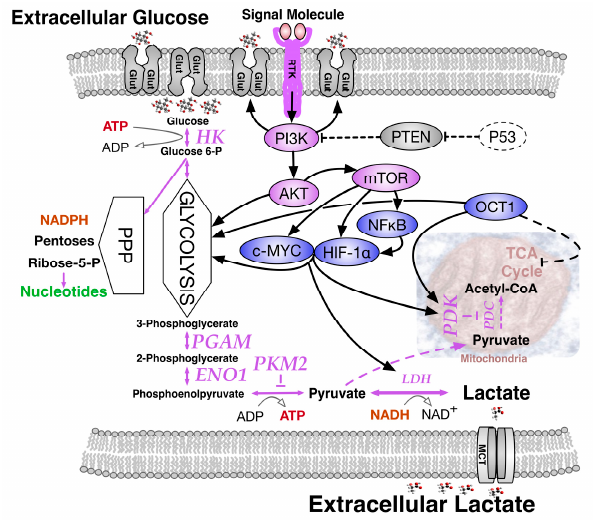
Figure 2. Molecular changes driving the Warburg effect. The shift to aerobic glycolysis in tumor cells reflects multiple oncogenic signaling pathways. Downstream from an active RTK, receptor tyrosine kinase, PI3K, Phosphatidylinositol 3-kinase activates AKT, protein kinase B/Akt strain transforming, stimulating glycolysis by directly regulating glycolytic enzymes. It also activates mechanistic target of rapamycin, mTOR, a protein kinase altering metabolism in various ways, including enhancement of three key transcription factors; the avian Myelocytomatosis viral oncogene proto-oncogene homologue (MYC); Nuclear factor kappa-light-chain-enhancer of activated B cells (NF- κ B); and the hypoxia-inducible factor 1 alpha (HIF-1 α ), to promote a hypoxia-adaptive metabolism. NF- κ B subunits bind and activate the HIF-1 α gene. HIF-1 α increases expression of glucose transporters, GLUT, glycolytic enzymes and pyruvate dehydrogenase kinase, PDK, that blocks pyruvate dehydrogenase complex, PDC driven entry of pyruvate into the tricarboxylic acid, TCA cycle. Transcription factor MYC cooperates with HIF-1 α to activate several genes encoding glycolytic proteins, yet also stimulates mitochondrial biogenesis whilst inhibiting mitochondrial respiration, favoring substrates for macromolecular synthesis in dividing cells. Tumor suppressor p53 ordinarily opposes the glycolytic phenotype via Phosphatase and Tensin homolog, PTEN but loss of p53 function (dashed line) is frequent in tumor cells. Octamer binding protein 1 (OCT1) activates transcription of genes that drive glycolysis and suppress oxidative phosphorylation. Change to the pyruvate kinase M2, PKM2 isoform affects glycolysis by slowing the pyruvate kinase reaction, diverting substrates into an alternative biosynthetic and reduced nicotinamide adenine dinucleotide phosphate, (NADPH)-generating pentose phosphate pathway, PPP. Phosphoglycerate mutase, PGAM and α -enolase, ENO1 are commonly upregulated in cancer as is the pyruvate kinase M2 isozyme, PKM2 allowing a high rate of nucleic acid synthesis, especially in tumor cells. Lactate dehydrogenase, LDH enhances production of lactate, a signaling molecule that can stabilize HIF-1 α and accumulate in the tumor microenvironment via Monocarboxylate Transporters, MCT, nourishing adjacent aerobic tumor cells that convert lactate to pyruvate for further metabolic processing. Solid black arrows, influenced targets; solid purple arrows, metabolite transition pathways; dotted purple arrows, reduced metabolite transition pathways; thin solid black arrow, coenzyme transition; dotted T-bar, inhibition.